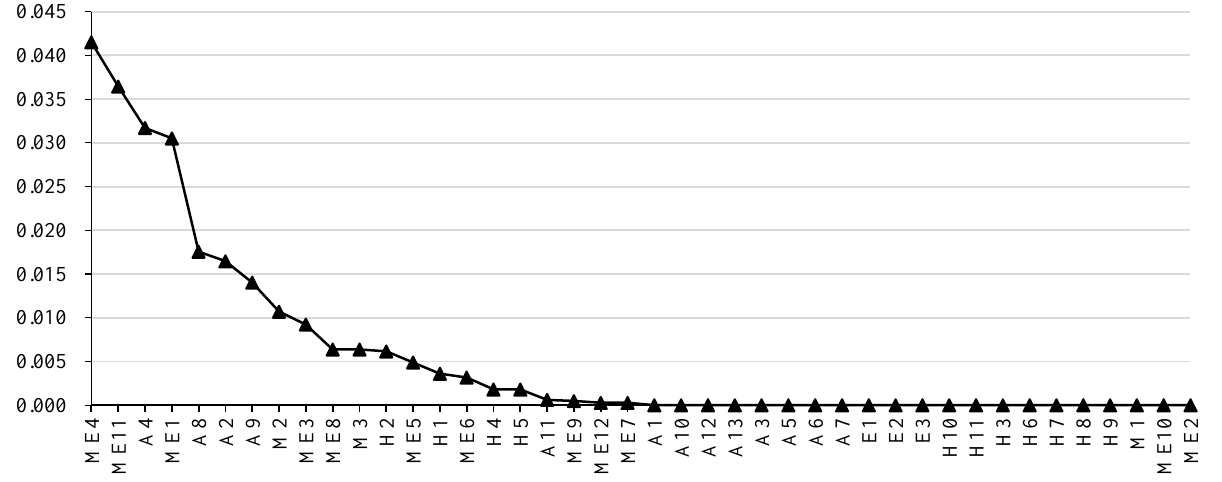
Figure 6. Values of vertex betweenness (see Tables 1 and 3 for the meanings of abbreviations).